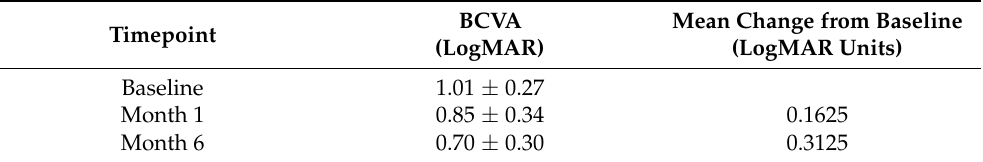
Table 3. Changes of best corrected visual acuity from baseline up to 6